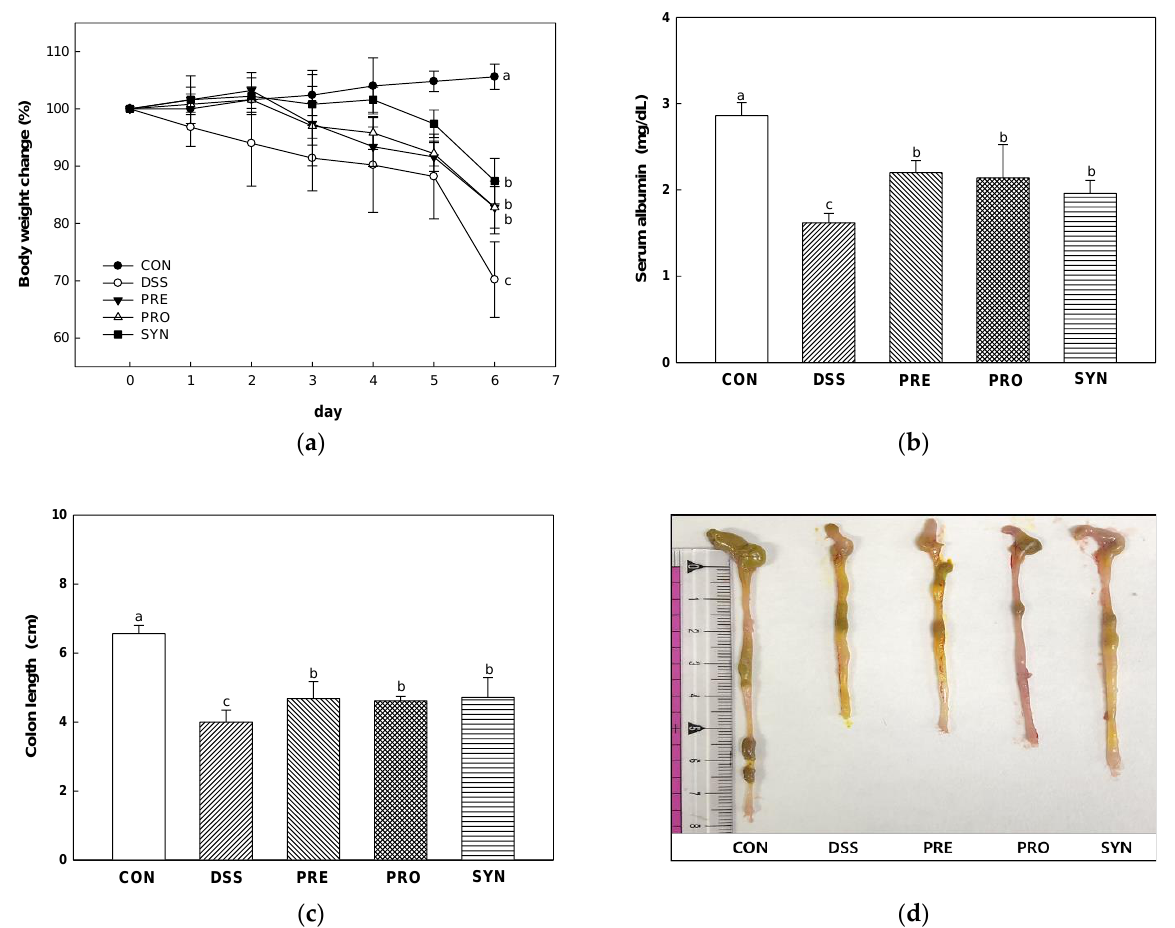
Figure 1. Effect of PRE, PRO, and SYN on pathological symptoms of DSS-induced colitis mice. The body weights change ( a ), serum albumin content ( b ), colon length ( c ), and macroscopic appearance ( d ). The results were presented as the mean ± SD ( n = 5). Data were statistically considered at p < 0.05, and different lowercase letters indicate significant differences between groups. Intestinal permeability was confirmed by measuring fluorescein-5-isothiocyanate (FITC)-dextran content in serum and the expression levels of tight junction (TJ) protein in the colon tissue (Figure 2). FITC-dextran content was increased in the DSS group (509.19 µ g/mL) compared to the CON group (47.24 µ g/mL) (Figure 2a). However, the FITC-dextran content of the PRE, PRO, and SYN groups (384.48 µ g/mL, 200.28 µ g/mL, and 204.50 µ g/mL, respectively) was reduced compared to that of the DSS group. The results of TJ protein in the colon tissue are shown in Figure 2b,c. The expression levels of occludin (0.43) and claudin-1 (0.51) of the DSS group were decreased compared with the CON group (1.00). However, the expression levels of occludin (0.53, 0.54, and 0.67, respectively) and claudin-1 (0.76, 0.74, and 0.86, respectively) of the PRE, PRO, and SYN groups were increased compared to that of DSS group.